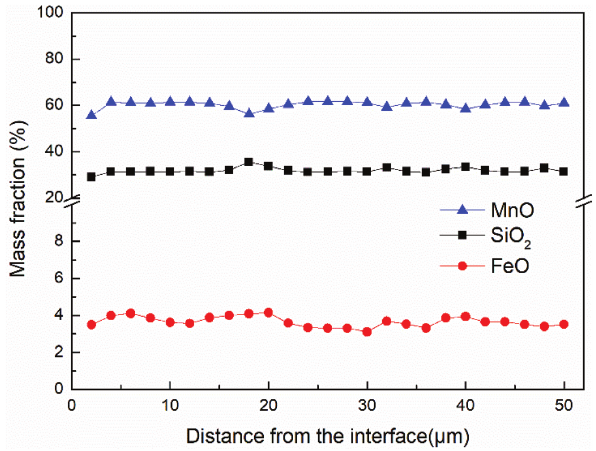
Figure 2: Concentration profiles of MnO, SiO 2 and FeO in the oxide near the interface before heat treatment.